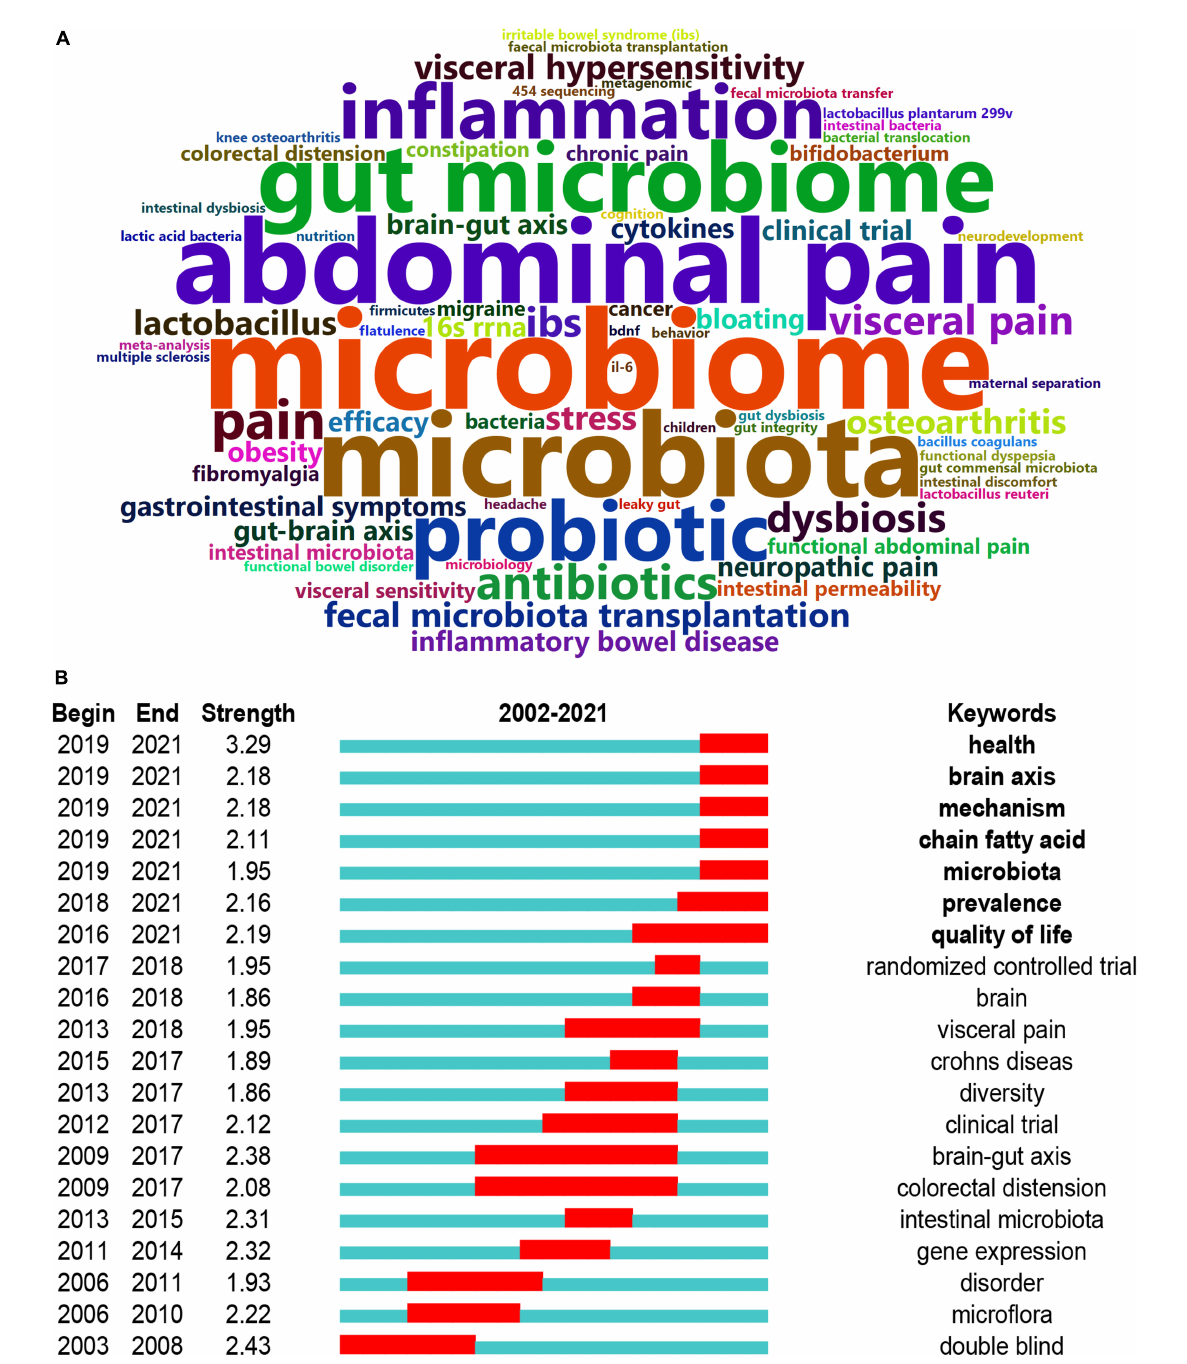
FIGURE7 Analysis of keywords. (A) The word cloud analysis of the top 50 high-frequency keywords on the links between the gut microbiota and pain between 2002 and 2021. (B) Keywords with the strongest citation bursts in original articles on the links between the gut microbiota and pain. Keyword marked in red indicates a sudden increase in usage frequency of this keyword during that period. Blue represents a relatively unpopular time